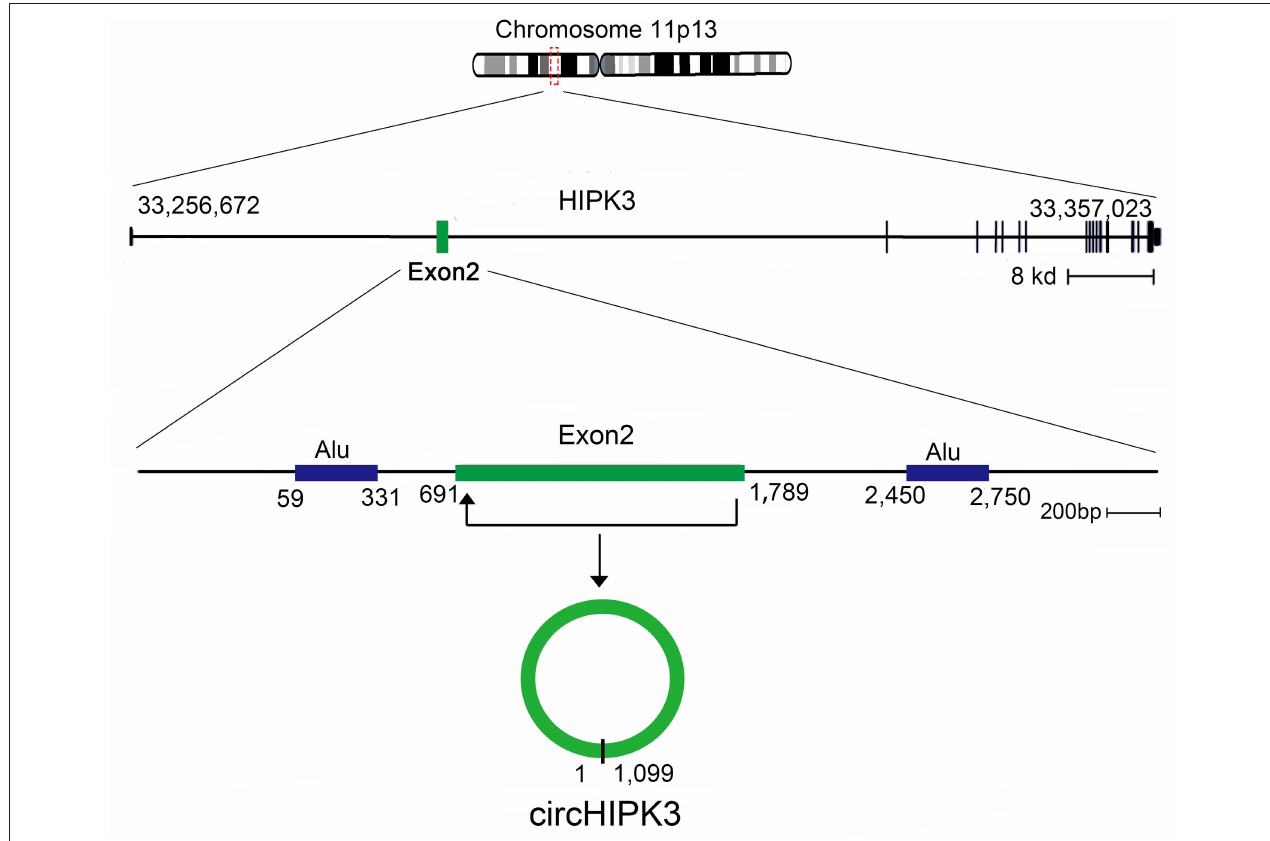
FIGURE 2 | Generation of circHIPK3. HIPK3 is located on chromosome 11p13, and the genomic regions of HIPK3 exon 2 contain flanking Alu repeats and long introns. HIPK3 yields an abundant 1,099 nt circular RNA comprised solely of exon